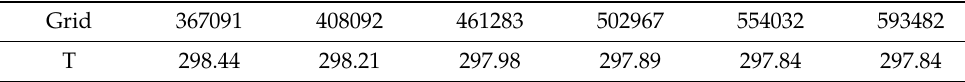
Table 3. The outlet TOB for different grid